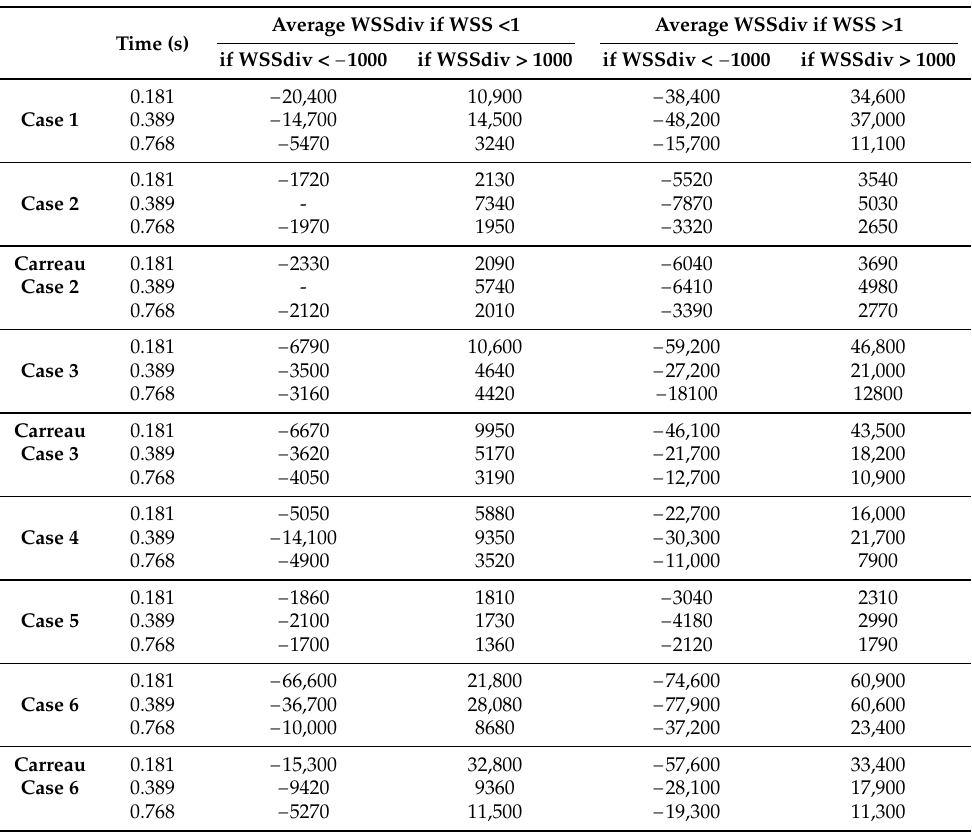
Table 4. Average values of WSSdiv as partitioned by WSS = 1 threshold. Only the aneurysm surface is considered. Units: WSSdiv (Pa m − 1 ), WSS (Pa). Results are presented to three significant